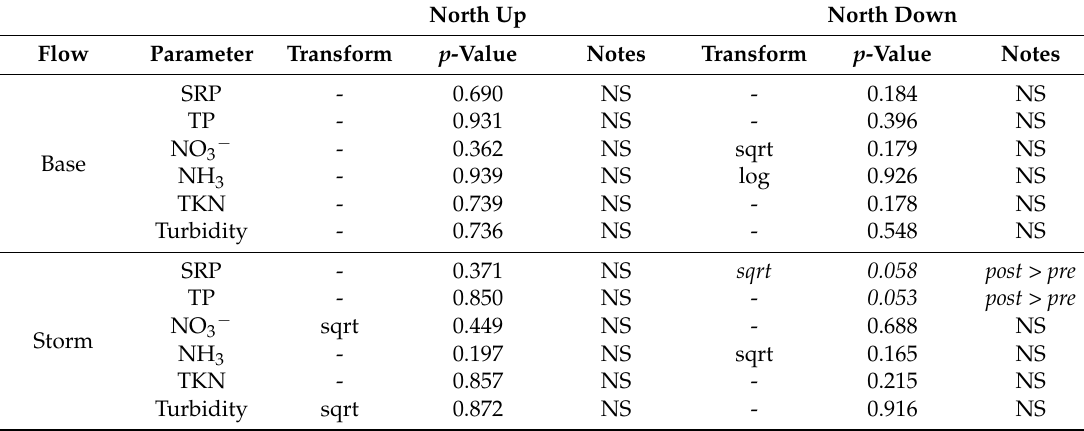
Table 11. Pre- vs. postrestoration statistical analyses of water quality at Haworth sites at baseflow and storm flow. To remove potential bias from pre- vs. postrestoration samples collected from different time periods, baseflow tests incorporated an equal number of samples from identical months in multiyear pre- and postrestoration periods (Apr., Jun., Jul., Sep., Oct., Nov., Dec., Jan., Feb., Mar., Apr., May, Jun., Jul., Aug., and Sep.). Storm flow tests incorporated all possible sampled storm events. North Up North Down Notes p -Value